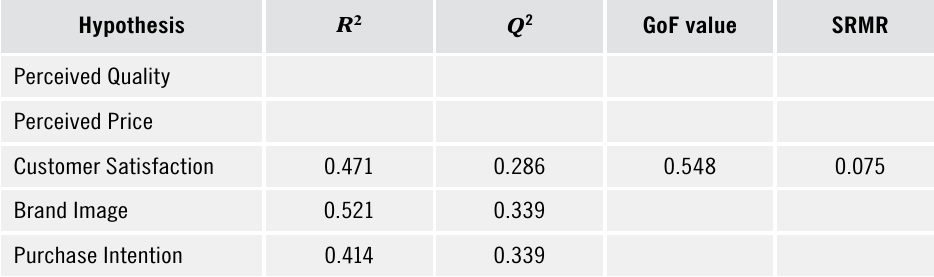
Table 5. Results of the prediction